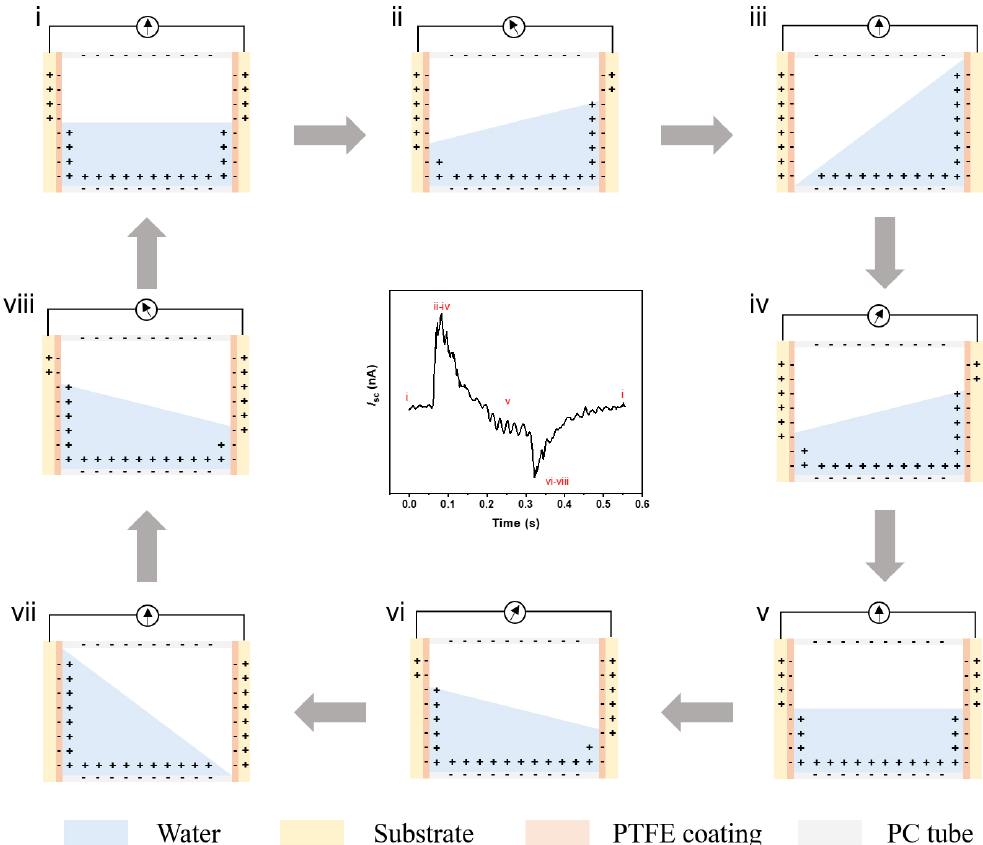
Fig. 3 Working mechanism of the hydrophobic TENG and the I sc during one vibration cycle of OP-60. (i–iii) Asymmetric accumulation process of OP-60 TENG from the equilibrium state to the right maximum asymmetric accumulation state, corresponding to the positive increasing of I sc . (iii–v) Asymmetric accumulation process of OP-60 TENG from the right maximum asymmetric accumulation state to the equilibrium state, corresponding to the positive decreasing of I sc . (v–vii) Asymmetric accumulation process of OP-60 TENG from the equilibrium state to the left maximum asymmetric accumulation state, corresponding to the negative increasing of I sc . (vii–i) Asymmetric accumulation process of OP-60 TENG from the left maximum asymmetric accumulation state to the equilibrium state, corresponding to the negative decreasing of I sc